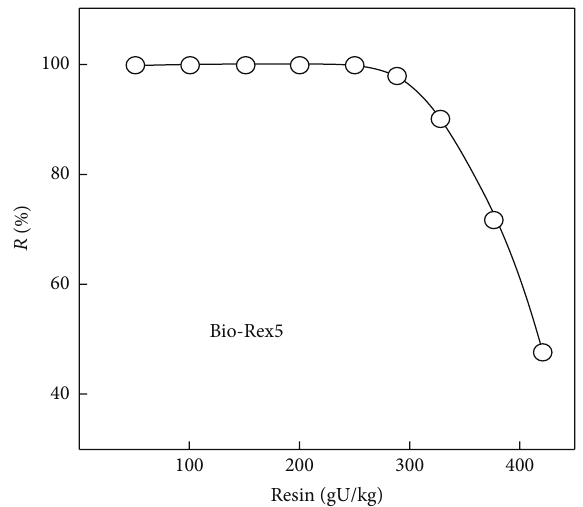
Figure 8: U-loading on Bio-Rex5 U 1: 3 HCO 3− /CO 3−2 .